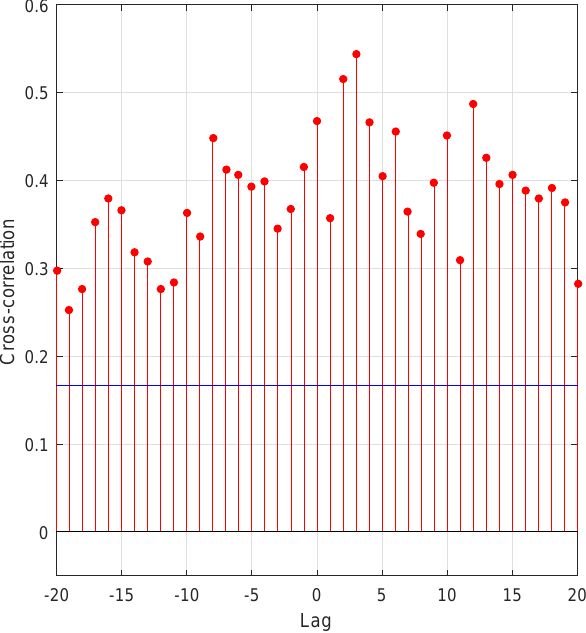
Figure 5. Cross-correlation between the monthly number of burglaries and robberies in beat